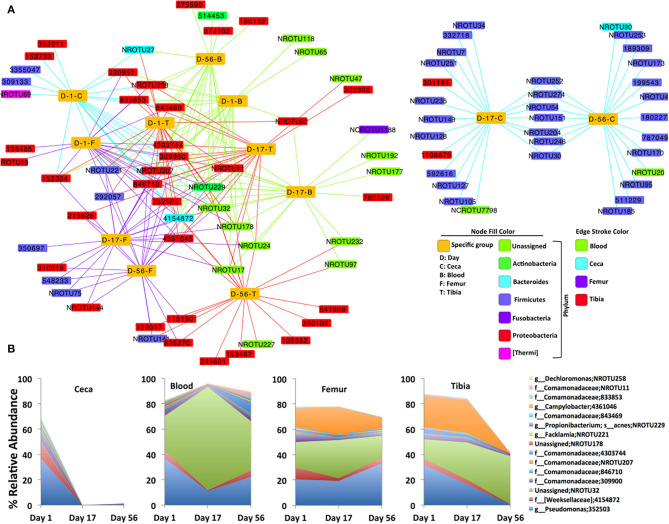
Bacterial OTUs interaction network. (A) Interaction of the top 20 abundant OTUs (small rectangular node) and each specific group of samples (yellow large rectangular node). Bacterial OTUs frequently shared by the specific group of chickens are at the core of the network, while uniquely present in any specific group of chickens, are toward the periphery of the network. (B) Area plot indicates the relative abundance of 15 most frequent OTUs that are at least shared by six specific groups of chickens (yellow node) in the bacterial network. Highest taxonomic rank is followed by OTU. NR: new reference, NCR: new cleanup reference, s, species; g, genus; f, family.